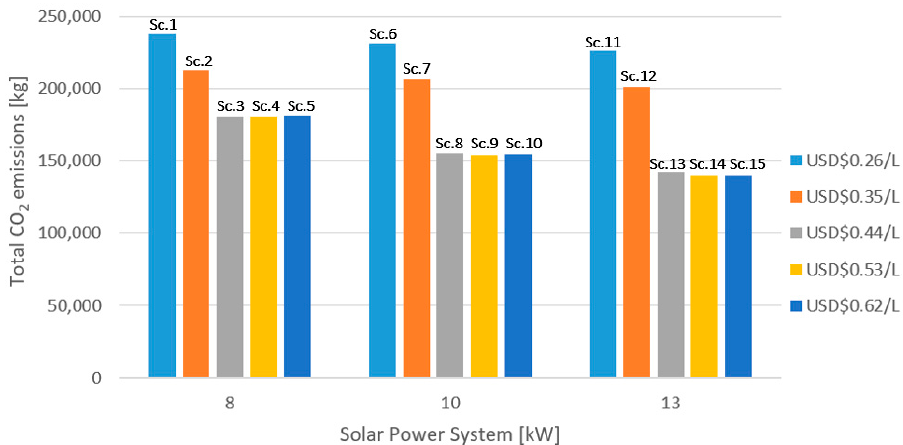
Figure 7. Amount of total CO 2 emissions by each SPS size with its fuel prices over the 15-year pro- ject period.